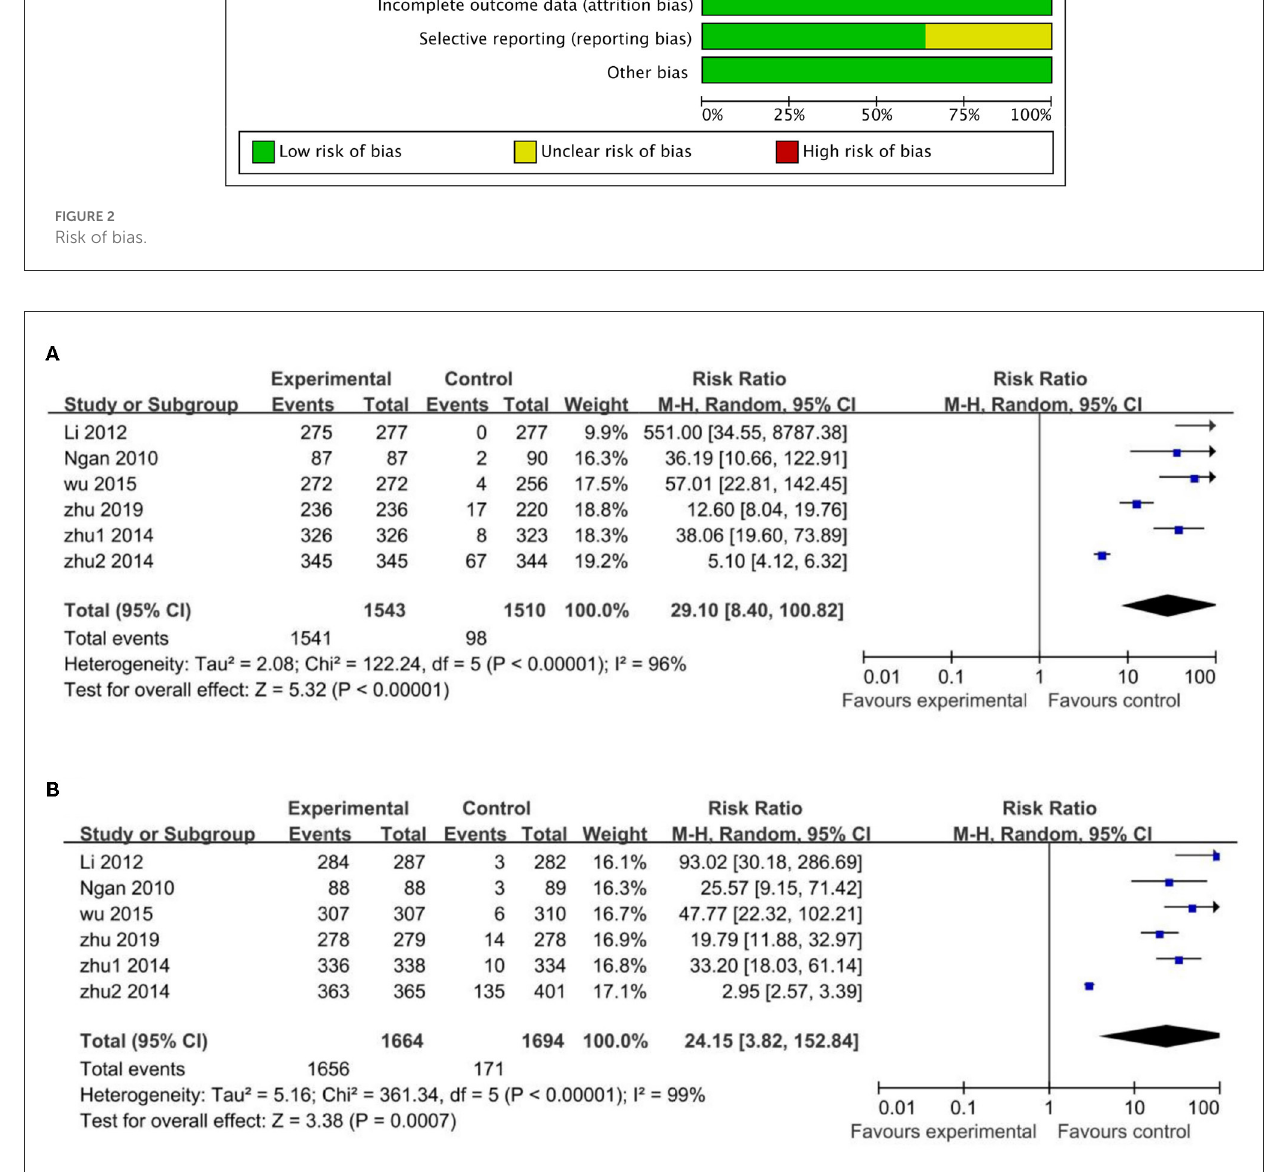
FIGURE3 Comparison HPV vaccines vs. control in HPV-16 (A) and HPV-18 (B) antibody seroconversion rate in uninfected Chinese population.